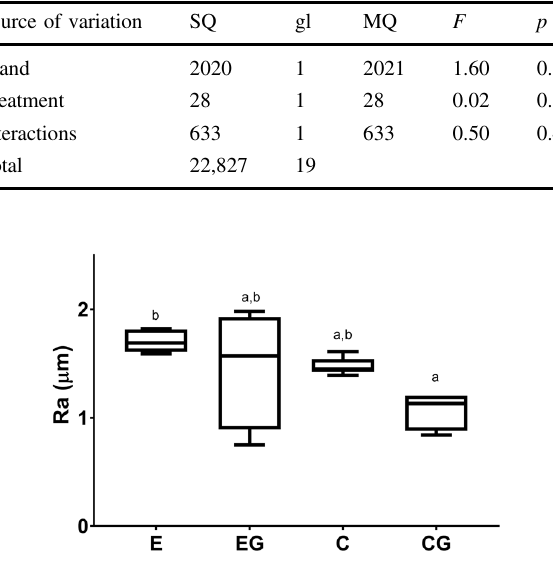
Fig. 3 Box plot graphic of median roughness (Ra, in μ m). Different lowercase letters denote signi fi cant differences among the groups